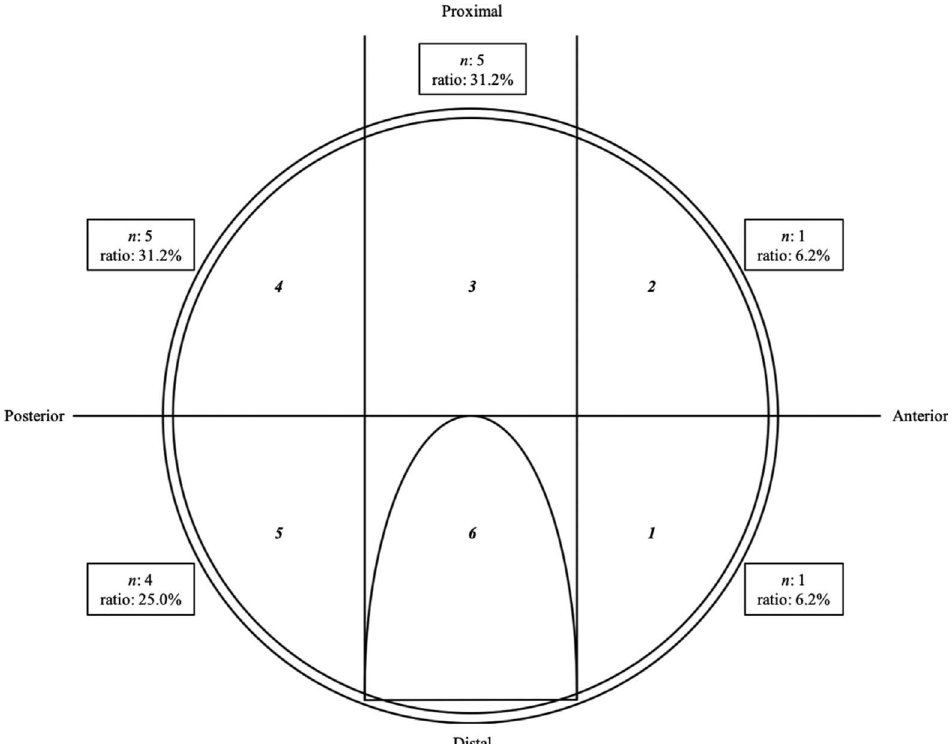
Figure 3. The presence and location of labral lesions documented using a geographic zone method. The labral abnormality lesions were assigned numbers and ratios (the number of lesions divided by the total number of lesions) correlating with their zone. Overall, 16 labral abnormalities were found in 9